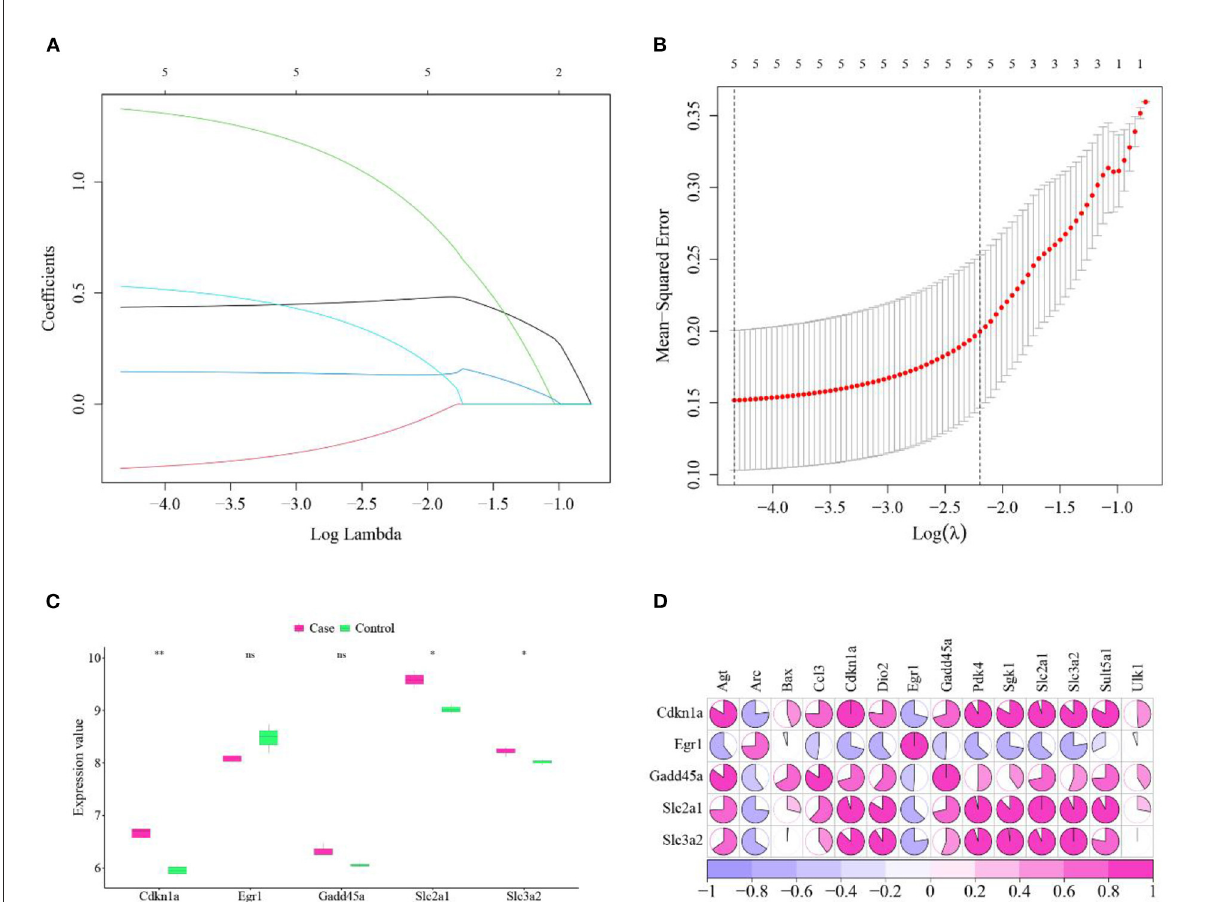
FIGURE5 Hub cross talk gene screening and analysis. (A) LASSO analysis results, each line in the figure represents a gene. When a gene tends to 0, the larger the value of the abscissa (Log Lambda), the more critical the gene is. (B) Results of model cross-validation. There are two dashed lines in the figure, one is the λ value lambda.min when the mean square error is the smallest, and the other is the λ value lambda.1se when the distance from the mean square error is the smallest one standard error, you can choose one of these two values, the dotted line The corresponding number is the result of the number of screening genes, here we choose lambda.1se as the screening condition for key genes. (C) Hub cross talk gene expression and t -test. The smaller the P value value of the test result, the more significant the sample difference results, and the more “*” on the graph. The corresponding relationship between the P value and the “*” sign is ns: P > 0.05, *: P ≤ 0.05, ** P ≤ 0.01, *** P ≤ 0.001, **** P ≤ 0.0001. (D) Correlation between hub cross talk gene and non-hub cross talk